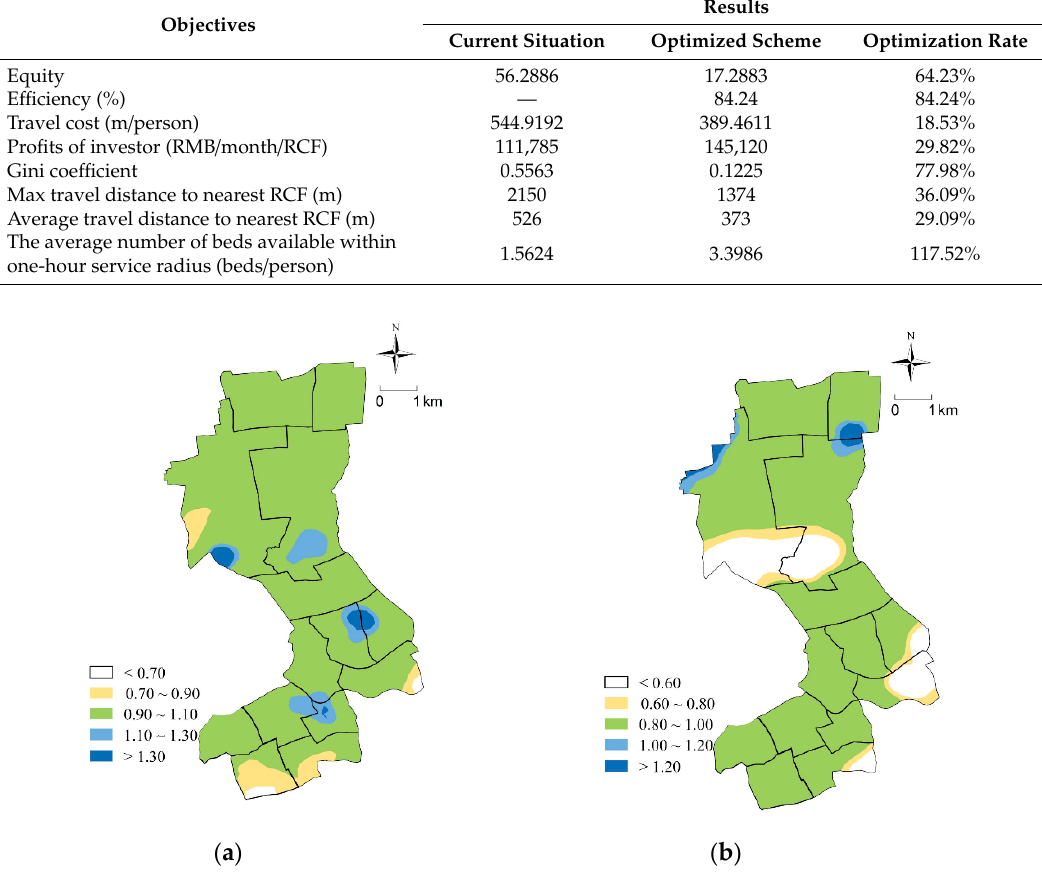
Figure 6. Analysis of optimization results. If there are multiple panels, they should be listed as: ( a ) Ratio of accessibility and the average value; ( b ) ratio of per capita travel costs before and after optimization.